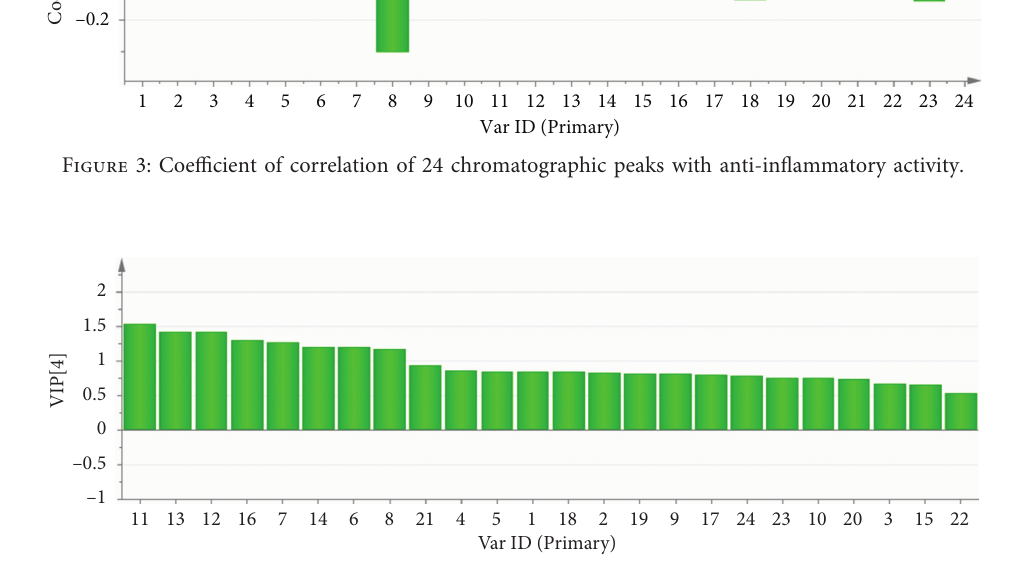
Figure 4: Variable importance in projection scores predicted the anti-inflammatory activity of 24 chromatographic peaks in the Qing Jin Hua Tan Tang extracts.